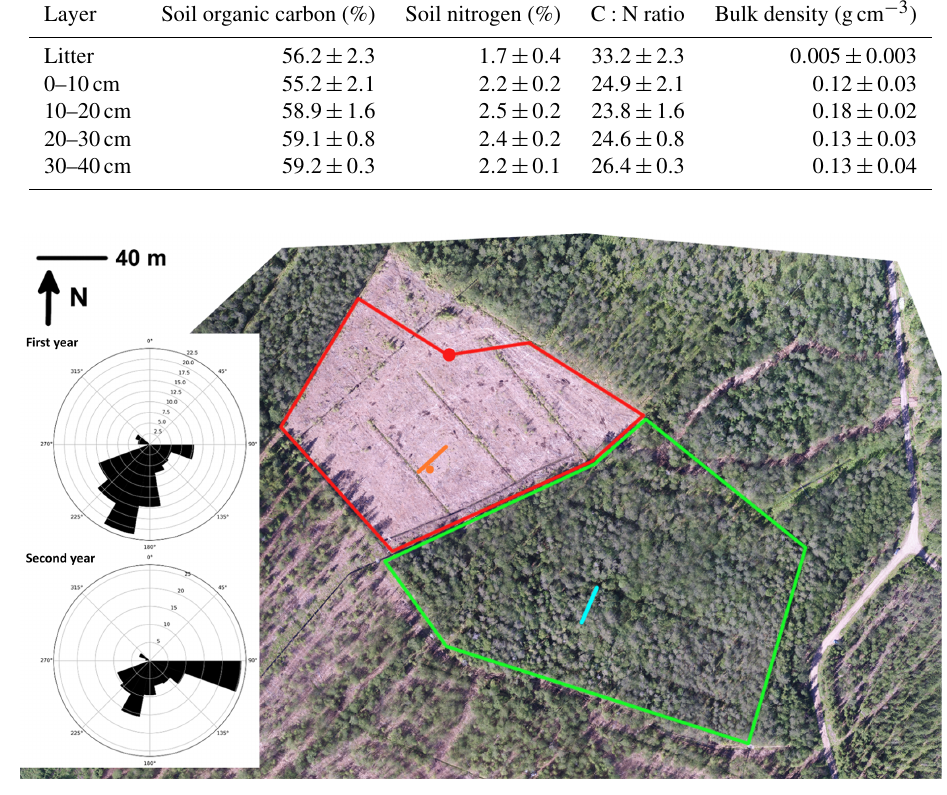
Figure 1. Aerial view of the clear-cut site and the surrounding forest at Lettosuo. The red dot shows the location of the eddy covariance mast, and the red lines surround the target area (80–315 ◦ ). The meteorological measurements were conducted at the location indicated by the orange dot, while the orange line marks the water table, soil temperature and chamber measurements (4, 8, 12 and 22.5m from the ditch). Similar measurements of greenhouse gas fluxes, water table and soil temperature within the control site, surrounded by the green lines, are shown with a light blue line. The wind roses on the left show the cumulative footprint contributions (in percentage) of the accepted flux